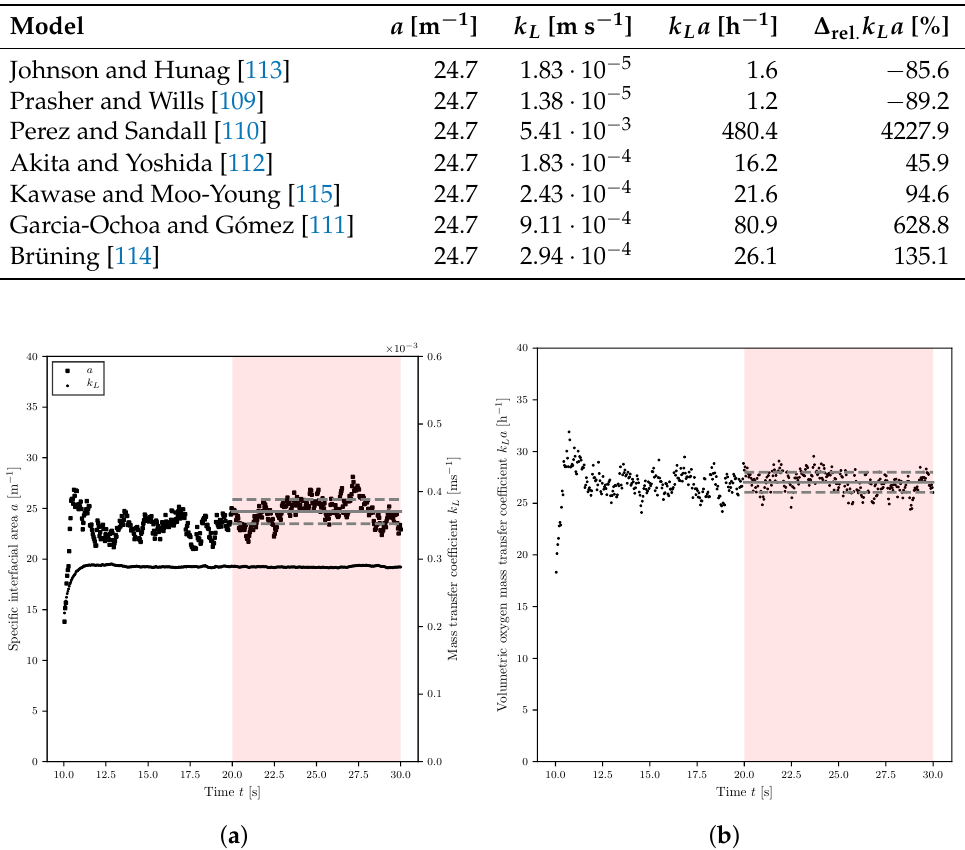
Figure 3. Temporal progression of ( a ) the k L , a and ( b ) k L a values for the base simulation. The gas supply was switched on at time t = 10s. For the k L a value, the time interval 20s to 30s was evaluated (red highlighted). The mean value and the standard deviation are shown in